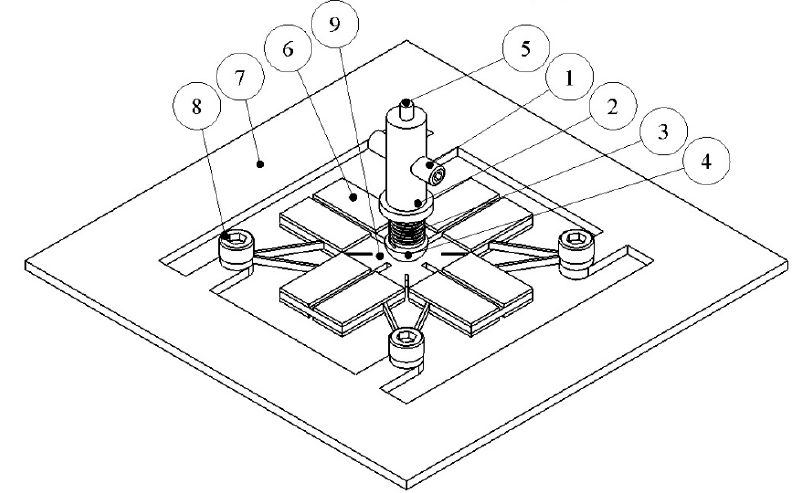
Figure 1. Design of the motor; 1—clamping bolts of preload spring clamp; 2—preload spring clamp;